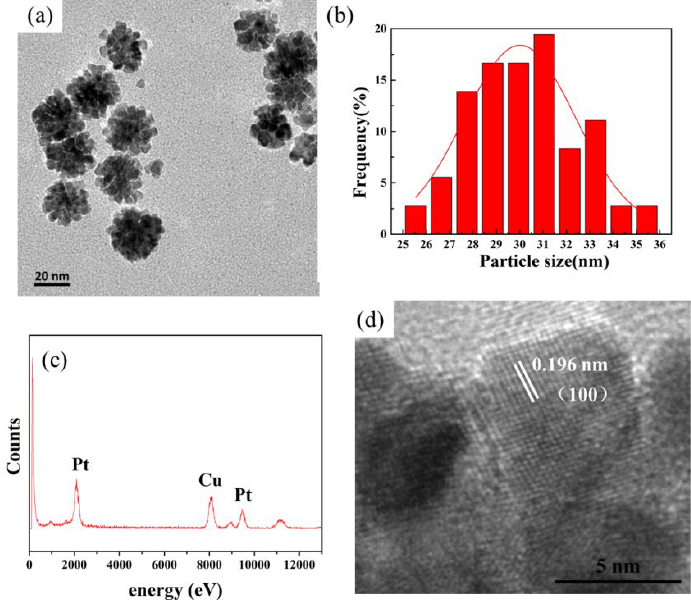
Figure 1. ( a ) TEM image of Pt nanoparticles (NPs), ( b ) size distributions of Pt NPs, ( c ) EDS elemental analysis of Pt NPs, and ( d ) HR-TEM image of Pt NPs.